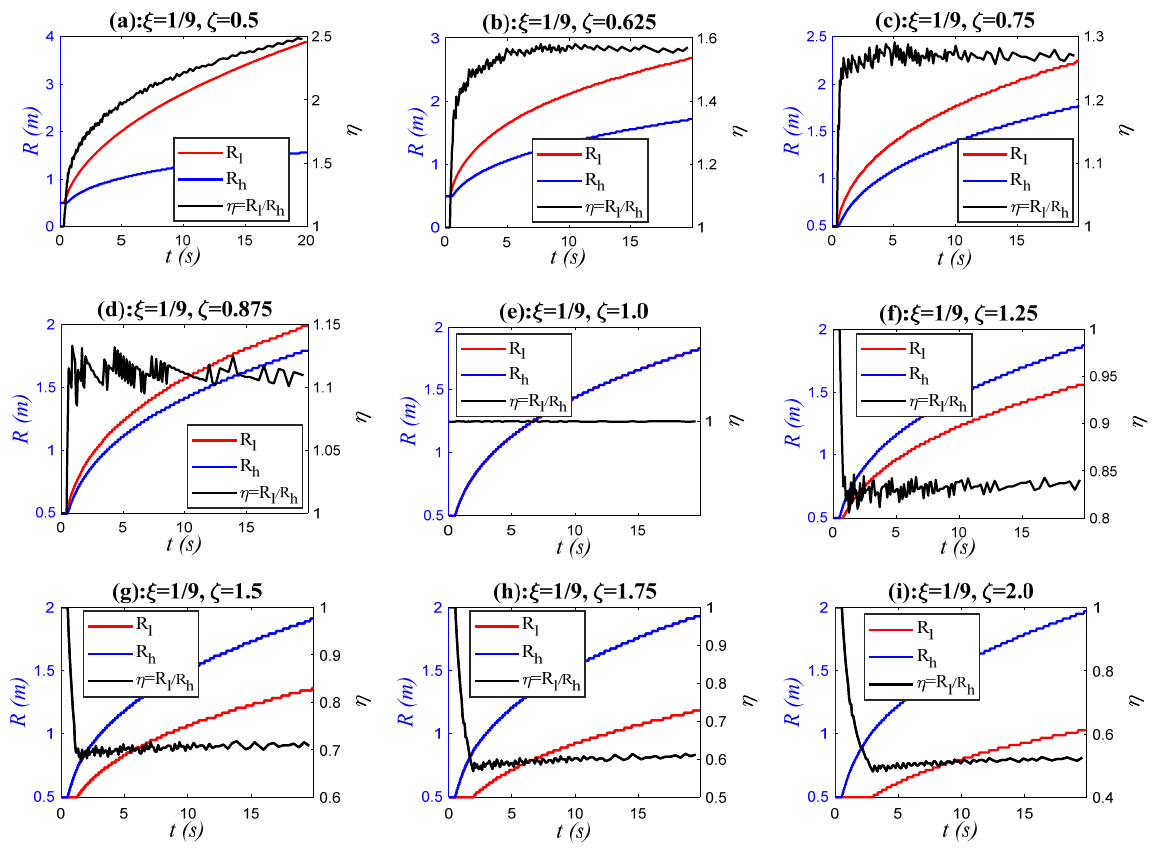
Figure 19. Relationships of the fracture “half-length” ( R l ), “half-height” ( R h ) and the fracture shape coefficient 𝜂 with respect to time for Group 1 experiments with 𝜉 = 1 9⁄ .